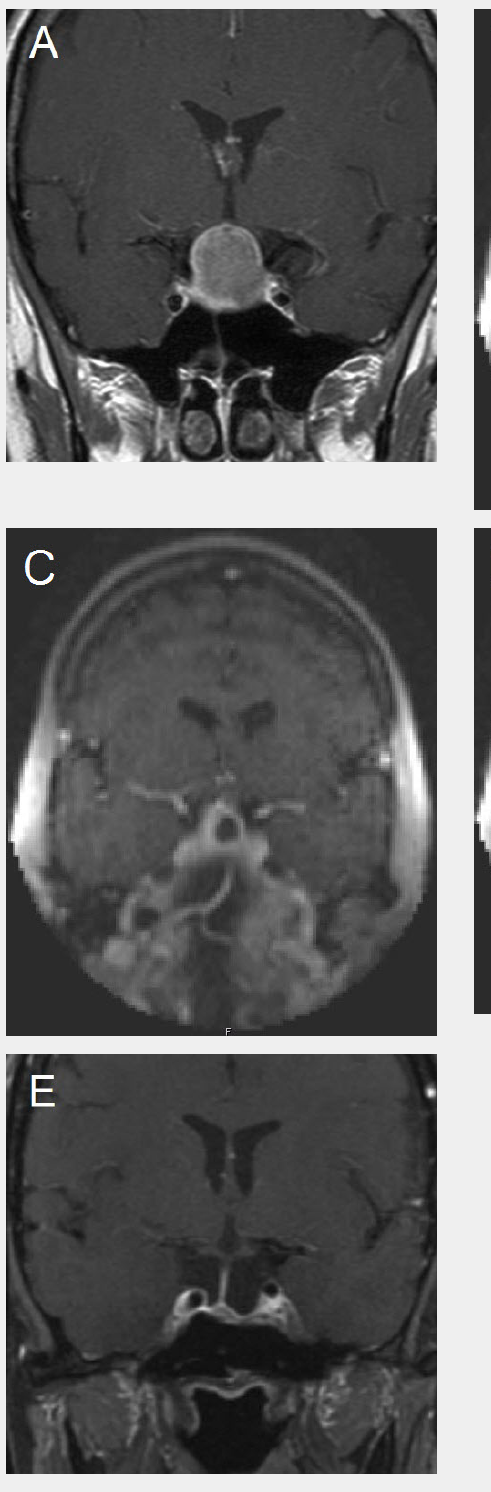
Illustrative case: Preoperative, intraoperative and postoperative imaging. A: Preoperative MRI, coronal view, contrast enhanced. B: Intraoperative MRI, coronal view, contrast enhanced, before skin incision. C: Intraoperative MRI, coronal view, contrast enhanced, during resection. D: Intraoperative MRI, coronal view, contrast enhanced, before closure. E: Postoperative MRI, coronal view, contrast